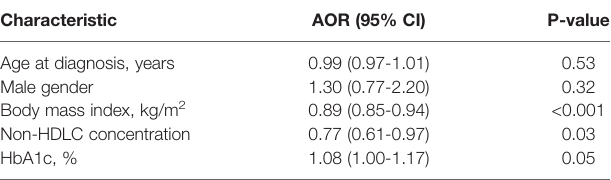
TABLE 2 | Multivariate analysis to identify the independent predictors of insulin de fi ciency.